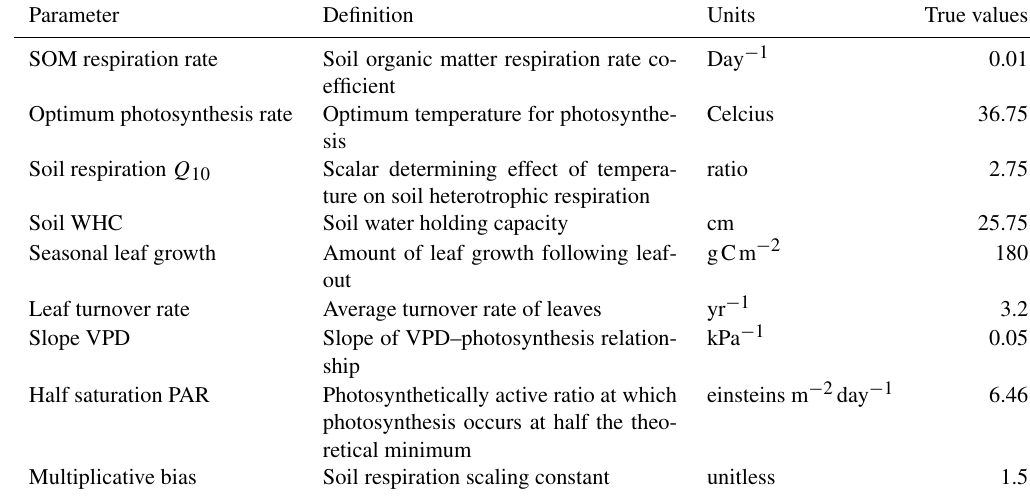
Table A3. Calibrated SIPNET parameters and the “true” values used to produce the synthetic data.